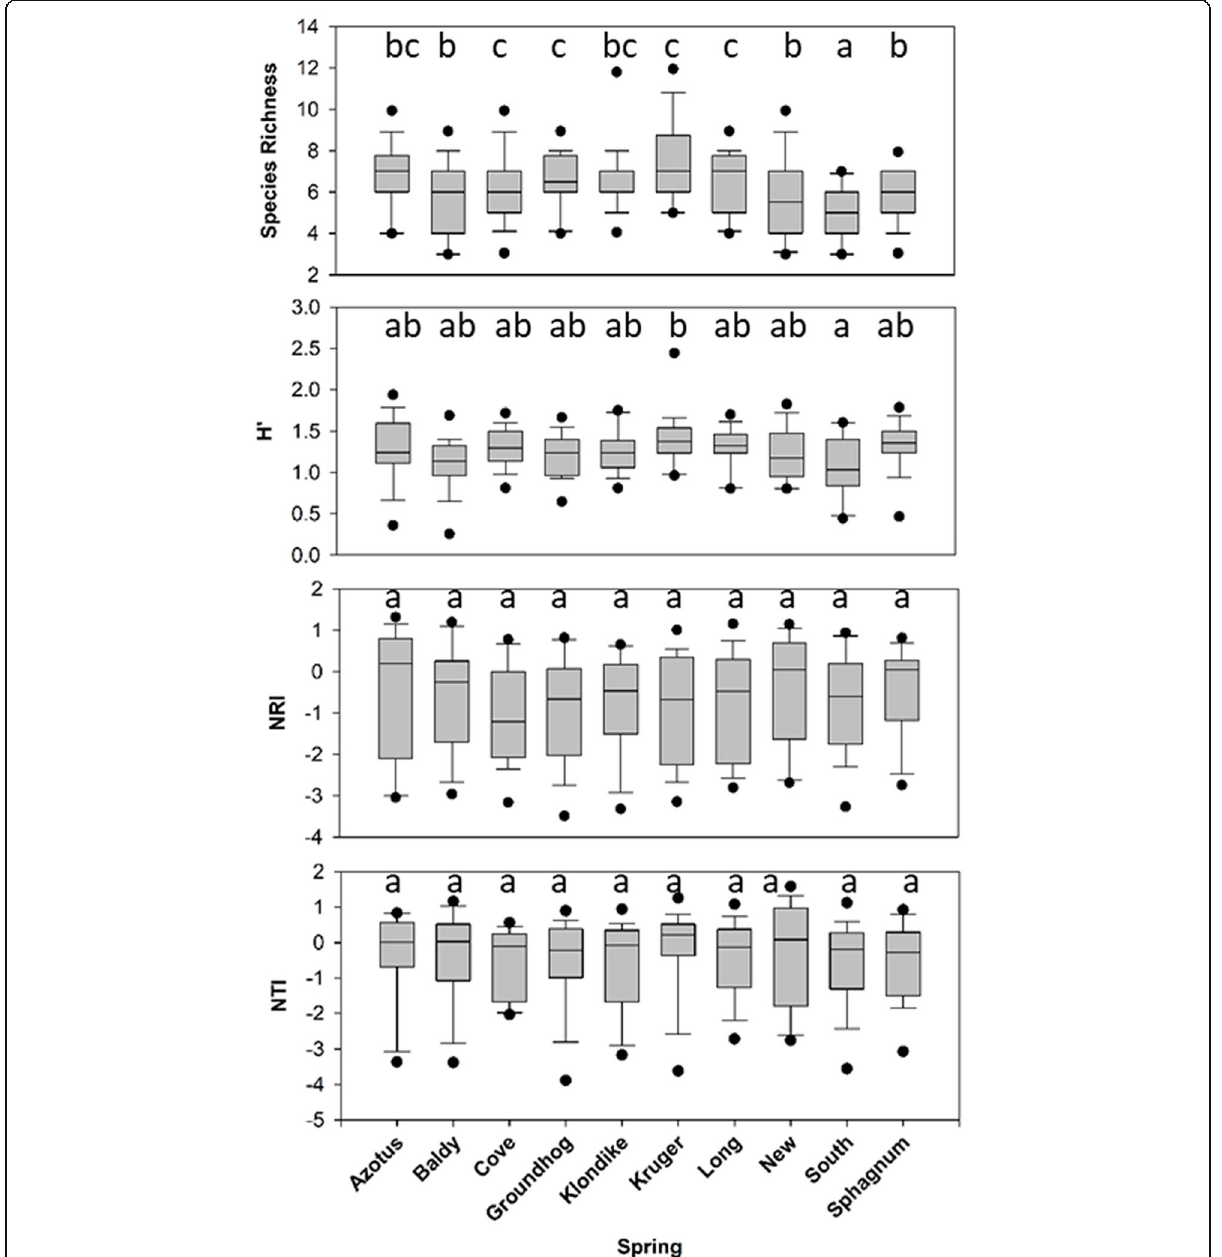
Fig. 2 Box and whisker plots of species richness (species per 1-m 2 plot), Shannon-Weiner diversity ( H ′ ), net relatedness index ( NRI ), and nearest taxon index ( NTI ) averaged from twenty individual 1-m 2 plots within each of the ten acid seep springs. Boxplots show the median (middle line within the box), interquartile range (25% quantile is the lower border of the box and 75% quantile is the upper border of the box), and extremes of the distribution. Acid seep springs sharing the same lowercase letter are not significantly different ( α = 005, Tukey ’ s LSD